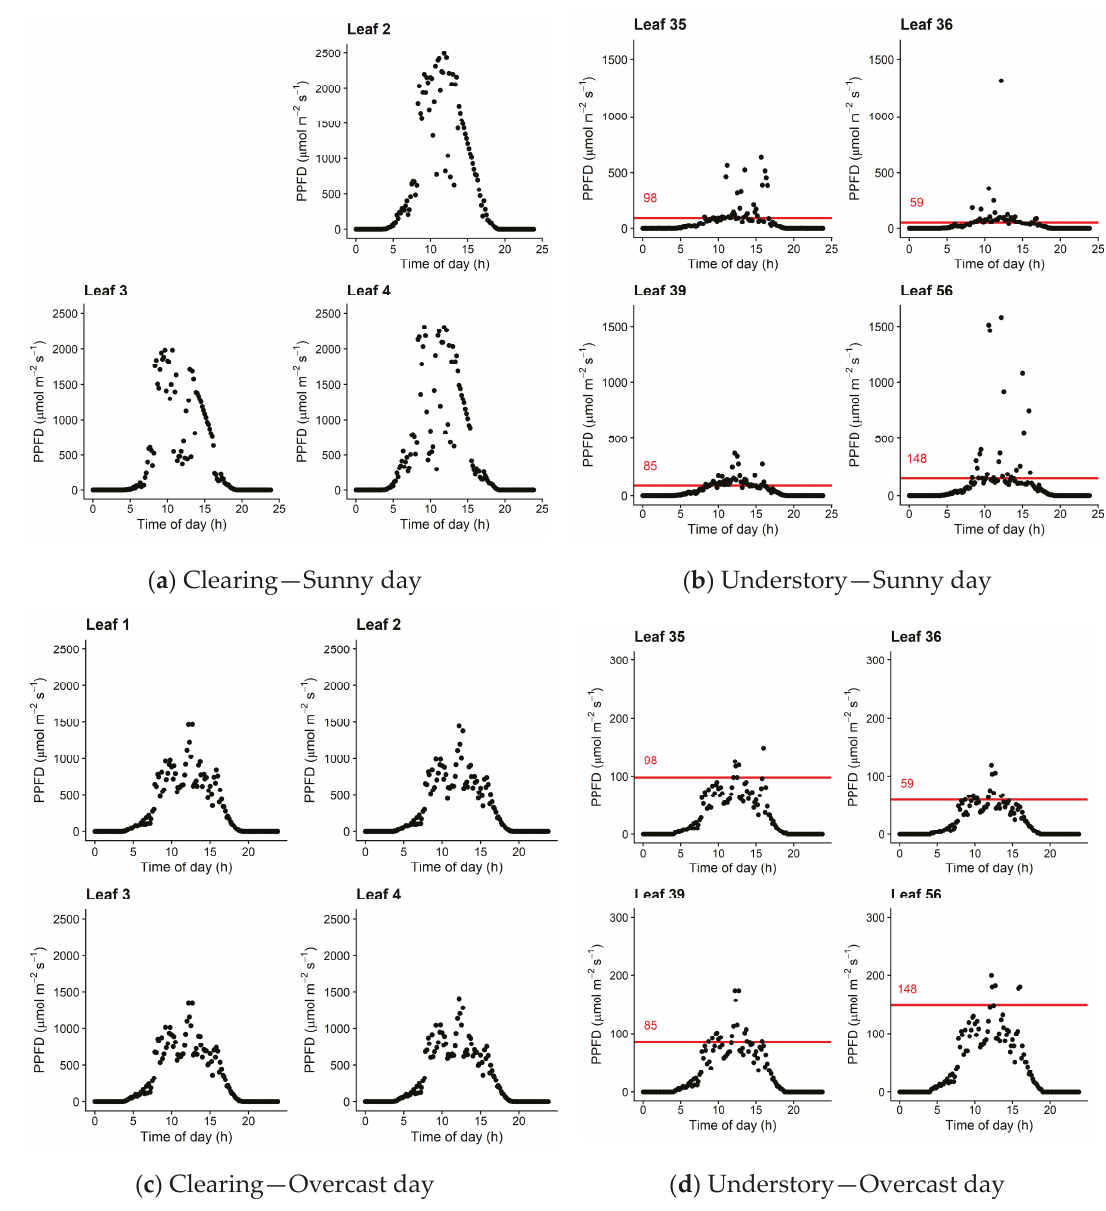
Figure 9. Diurnal course of light intensity (PPFD) incident on each leaf at each site (the clearing and understory) on a sunny day (3 July 2020) and on an overcast day (24 June 2020). ( a ) Clearing on the sunny day, ( b ) understory on the sunny day, ( c ) clearing on the overcast day, and ( d ) understory on the overcast day. Data for Leaf 1 on the panel ( a ) were not obtained owing to a measurement failure. The red horizontal lines on the understory panels indicate the critical values of PPFD; if PPFD at one moment exceeded that value, the instantaneous net photosynthetic rate would be higher for a typical clearing leaf than for the understory leaf in